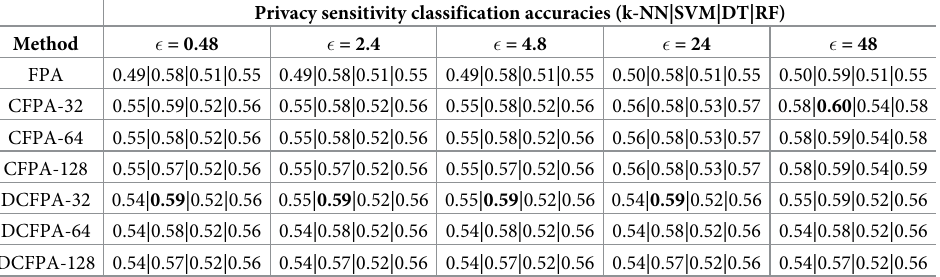
Table 4. Privacy sensitivity classification accuracies in the MPIIPrivacEye dataset using differentially private eye movement